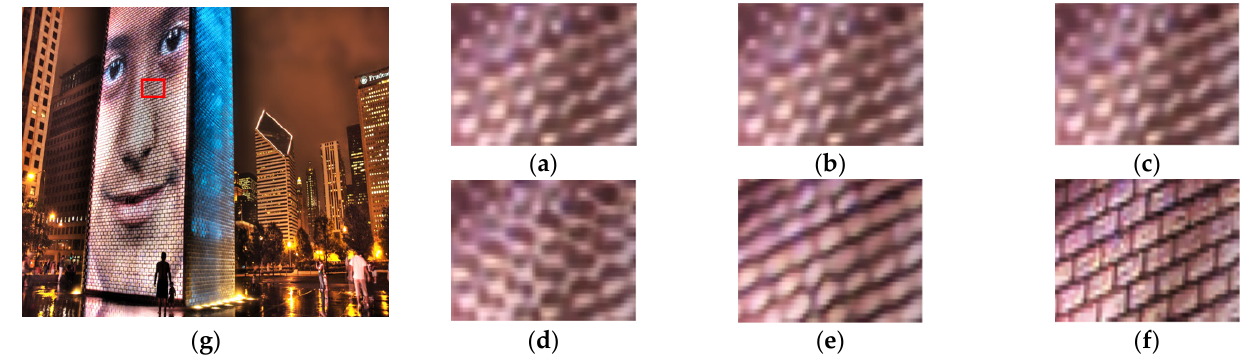
Figure 1. Visual results under × 4 upscale factor. ( a ) VDSR; ( b ) Lap-SRN; ( c ) Meta-SR; ( d ) RCAN; ( e ) IDMF-SR; ( f ) HR; ( g ) Urban100 img_76 (3 ×